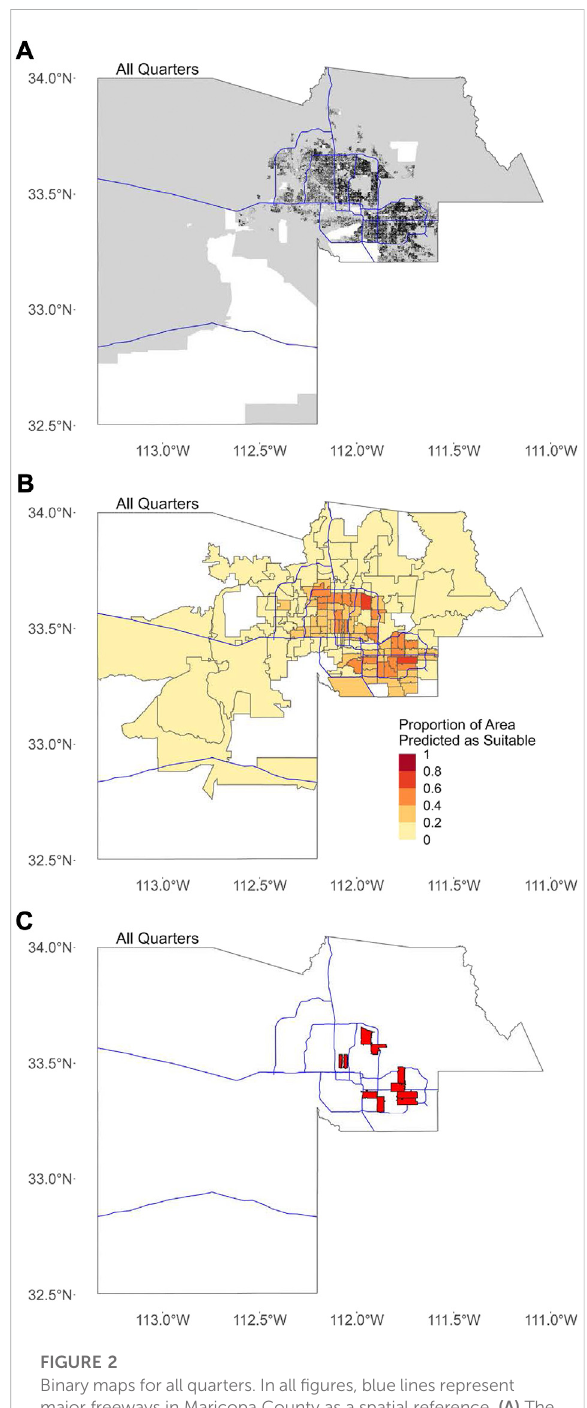
FIGURE 1 Averagepredictedsuitabilityforallquarters.Inall fi gures,blue lines represent major freeways in Maricopa County as a spatial reference. (A) Mapshowingthemeanpredicted suitabilityfor each 30-m by 30-m pixel, calculated as the mean of the predicted suitability for all 25 quarters. Areas with missing data where suitability was not predicted are shown in white. (B) Predicted suitabilityforallquartersaveragedbyZCTA. (C) Thelocationoften ZCTAs with the highest average suitability for all quarters.